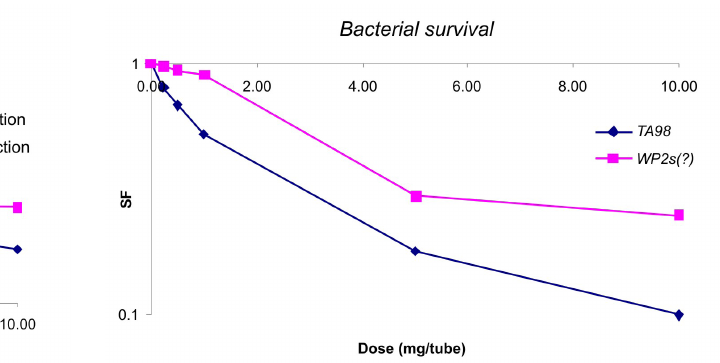
FIGURE 2 - Mutagenic Index (MI) as a function of dose (mg/tube) of “barbatimão” extract (BE), with or without S9 fraction on TA98. The maximum coefficient of variation (CV) of experiments was 10%. Plots represent average of four independent experiments.